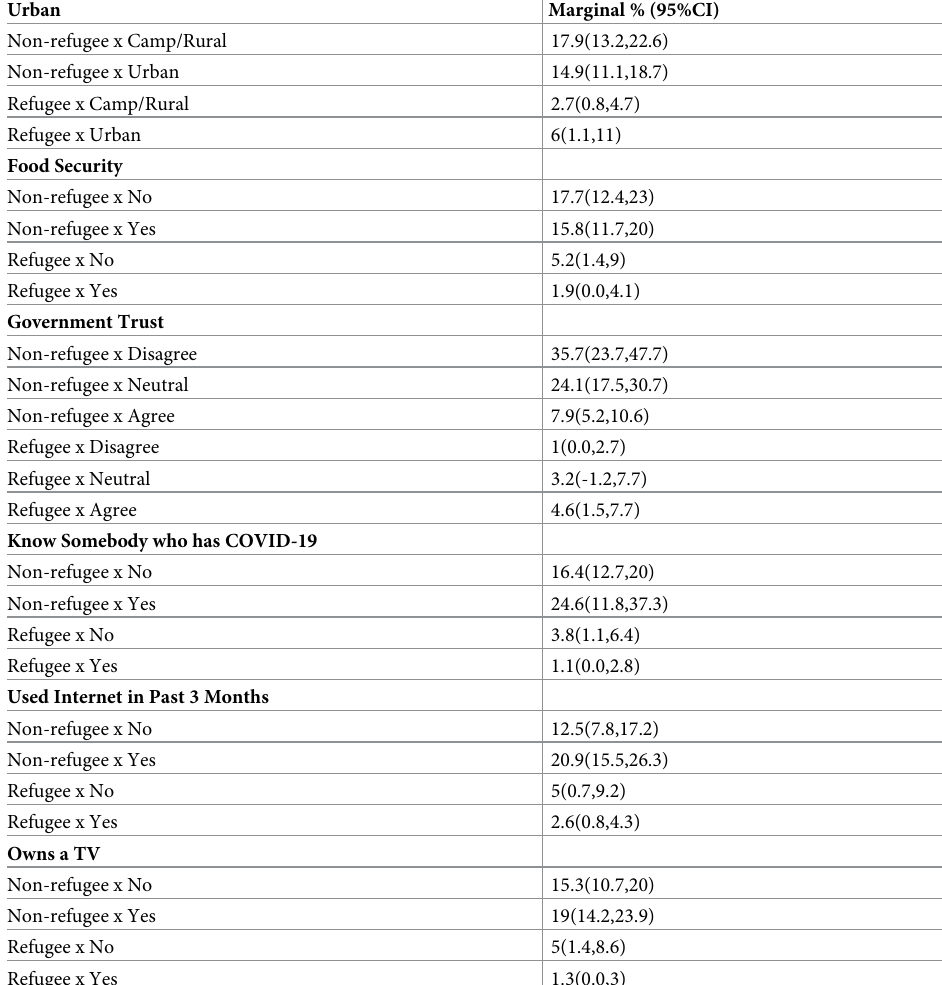
Table 2. Marginal percentages of vaccine hesitancy for interaction terms (with